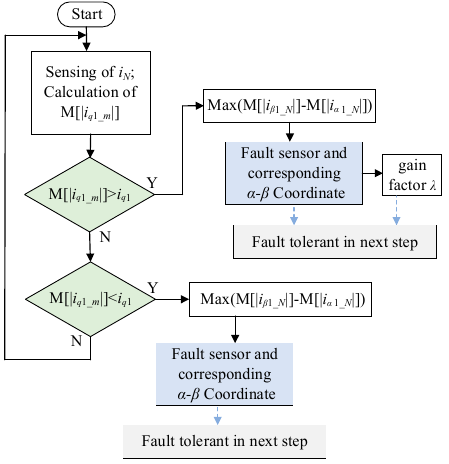
Figure 6. Flowchart of proposed method.